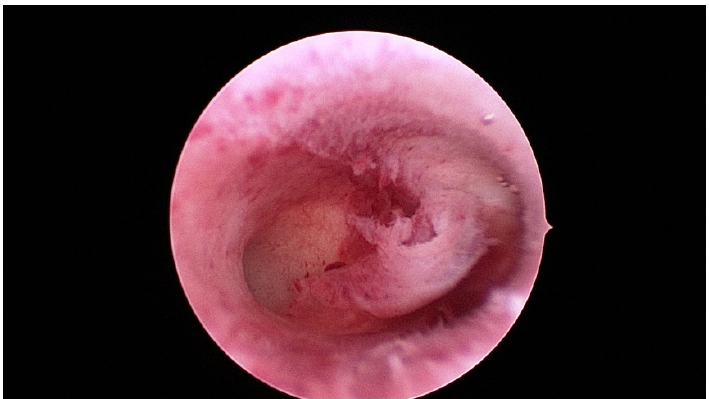
Figure 5. Hysteroscopic view of an inconspicuous cavum uteri with raised endometrium in the mid-